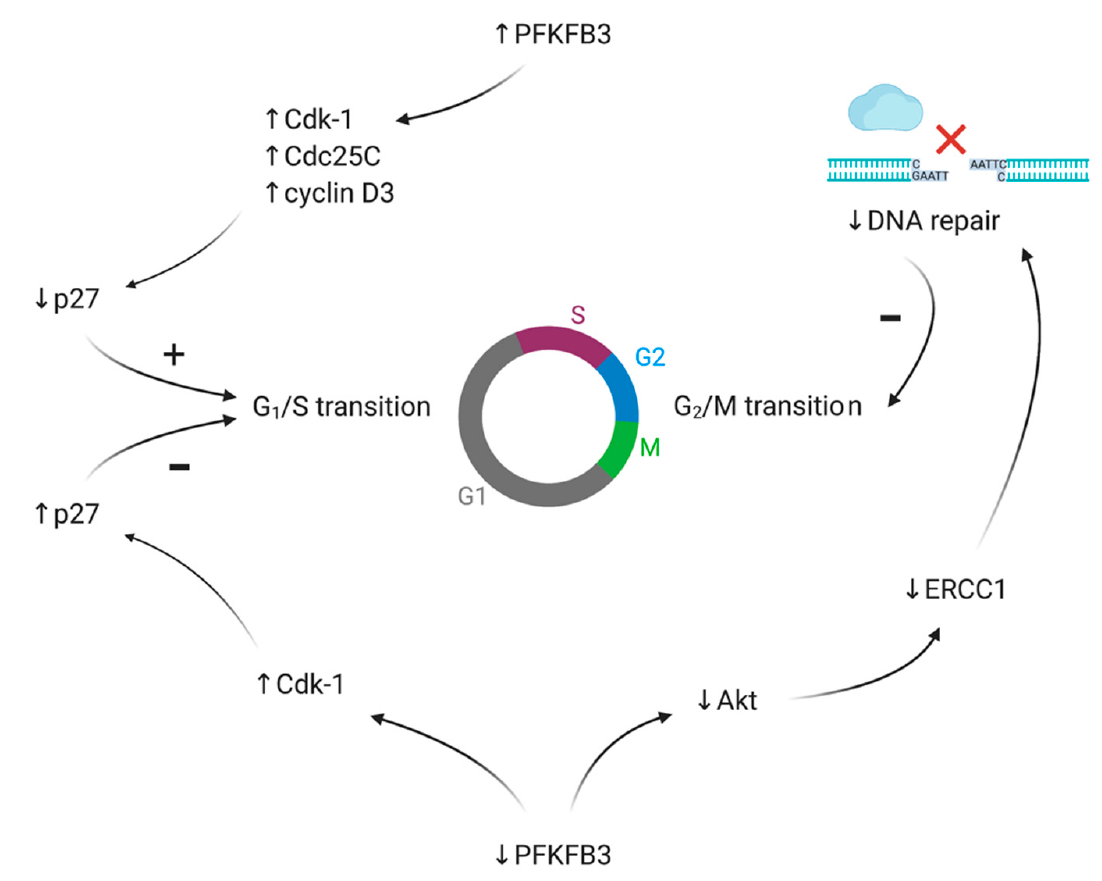
Figure 7. Graphical presentation of the PFKFB3 impact on cycle progression. Abbreviations: PFKFB3: 6-phosphofructo-2-kinase/fructose-2,6-bisphosphatase isozyme 3, Cdk-1: Cyclin-dependent kinase 1, Cdc25C: M-phase inducer phosphatase 3, cyclin D3: G1/S-specific cyclin-D3, p27: Cyclin-dependent kinase inhibitor 1B, Akt: Protein kinase B (PKB), ERCC1: Excision Repair Cross- Complementation Group 1. Created with BioRender.com.